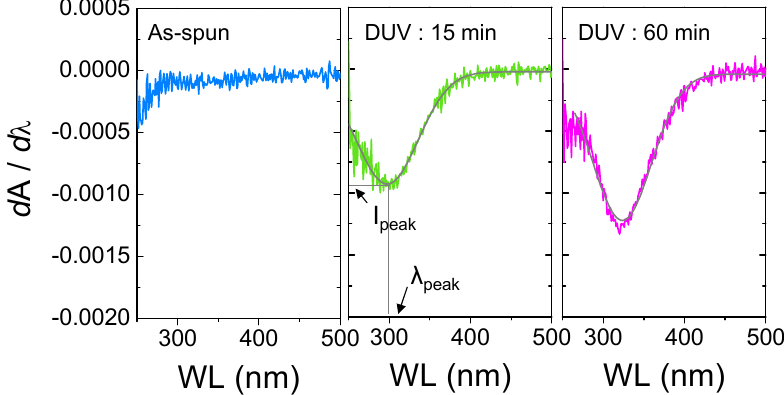
Figure 4. The first ‐ order derivatives of absorbance vs. wavelength ( A ʹ ‐λ ) and fitted curves of the photo ‐ activated IGZO films, and acquisition of peak center ( λ peak ) and peak intensity ( I peak ).